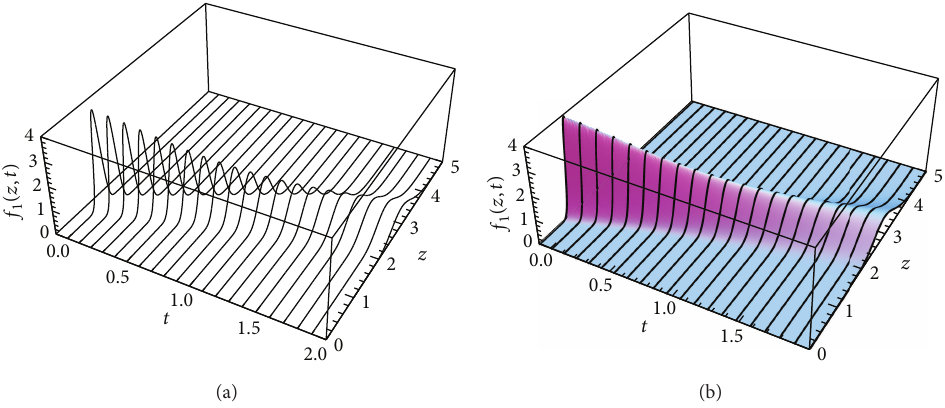
Figure 12: Plot of 𝑓 1 (𝑧,𝑡) given by (128)-(129) in Example 22 at different values of 𝑡 = {0,0.1, 0.2, . . . , 2} in the case that 𝜂 = (𝑍 0 ,𝐴) 𝑇 ∼ , Σ ) where 𝜇 Σ 𝑁(𝜇 𝜂 𝜂 𝜂 and 𝜂 are given by (127) with